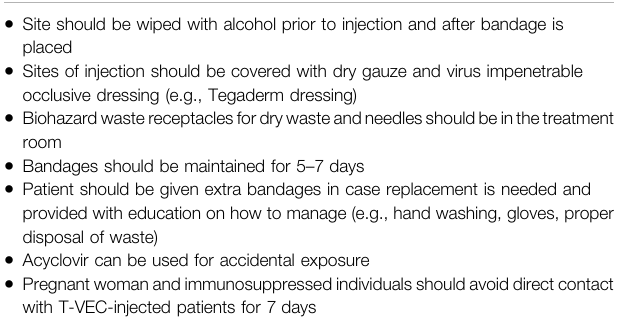
TABLE 4 | Considerations for patient management after T-VEC